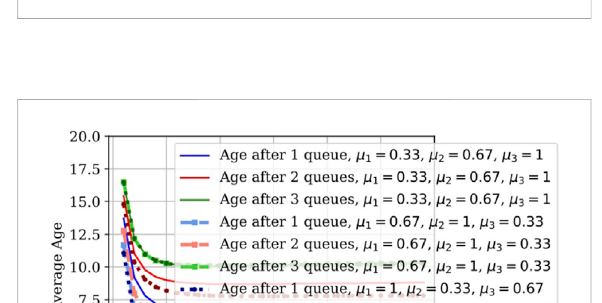
FIGURE 7 Averageagevs. λ ,different μ 1 , μ 2 queuecapacityofone,non-